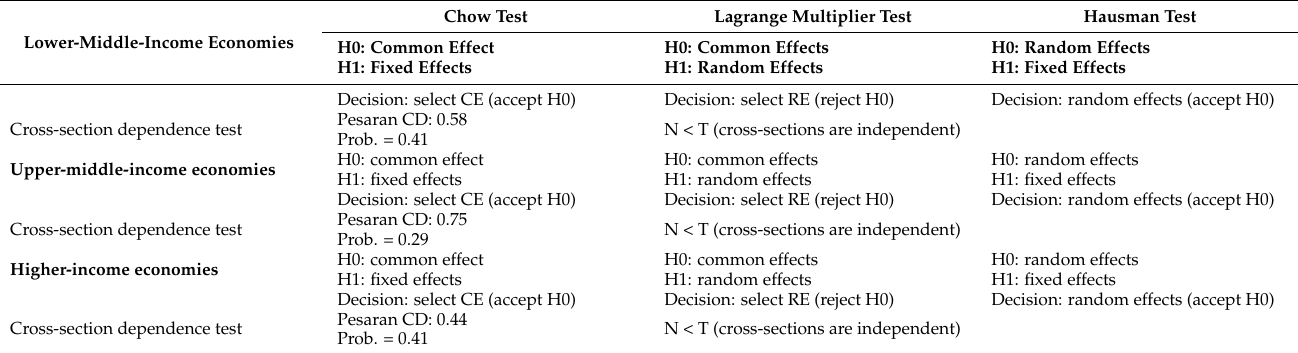
Table 8. Fixed and Random Effects for Panel